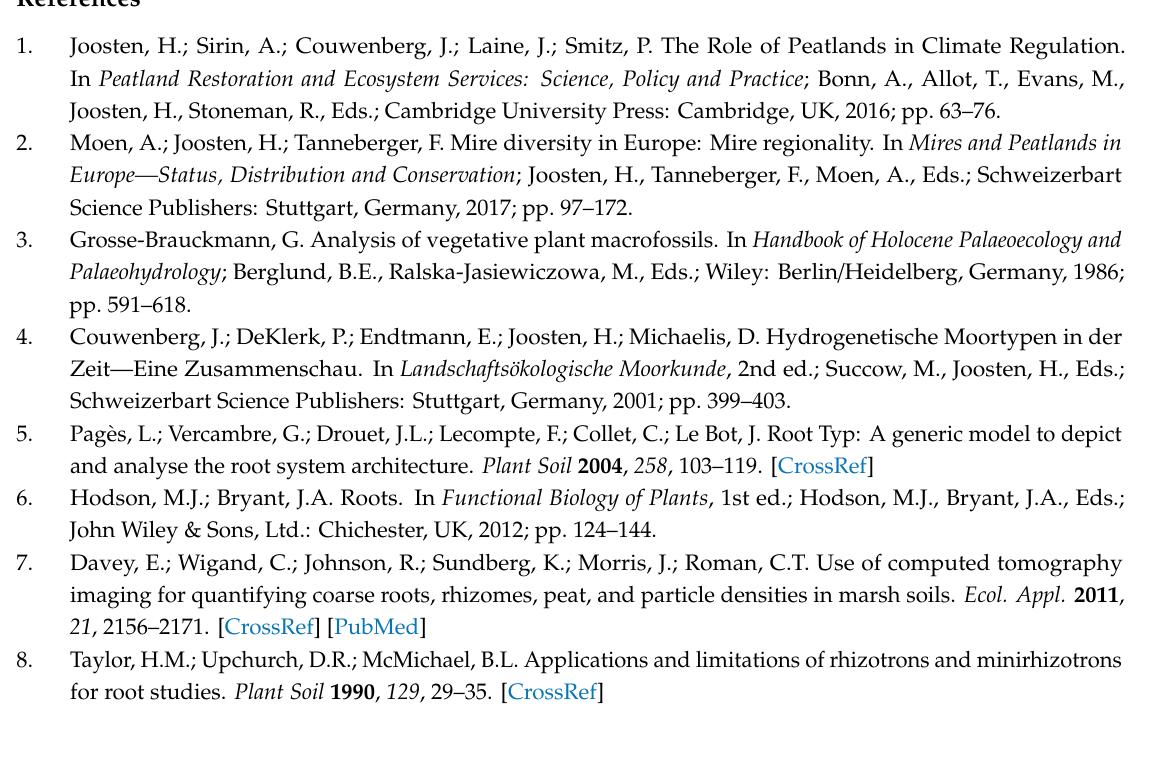
calculations of the input data, 3 cm sections of the RWSS models were created for